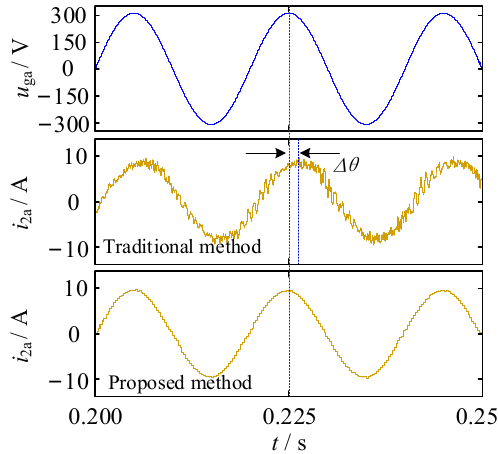
Figure 9. Simulation results of the grid current.